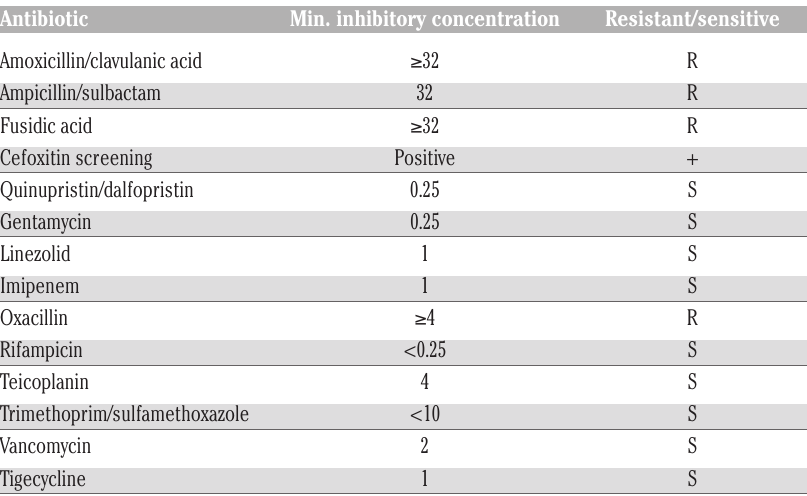
Figure 1. Pathophysiological mechanism of spontaneous bacterial Table 1. Antibiogram of Staphylococcus aureus isolate.